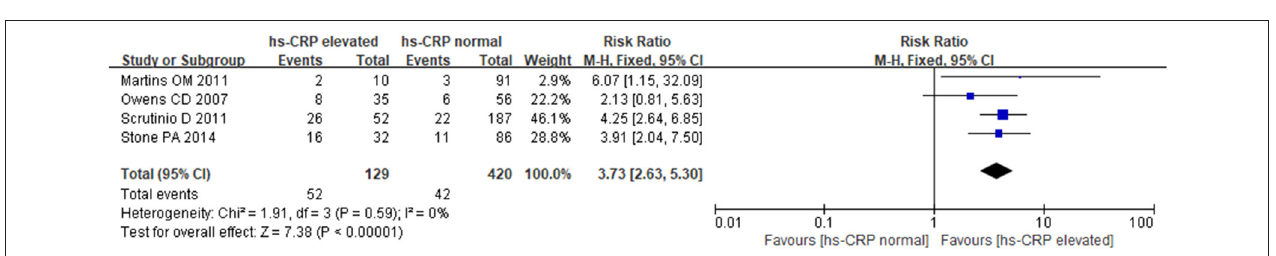
FIGURE 4 | The association between hs-CRP and MACE.